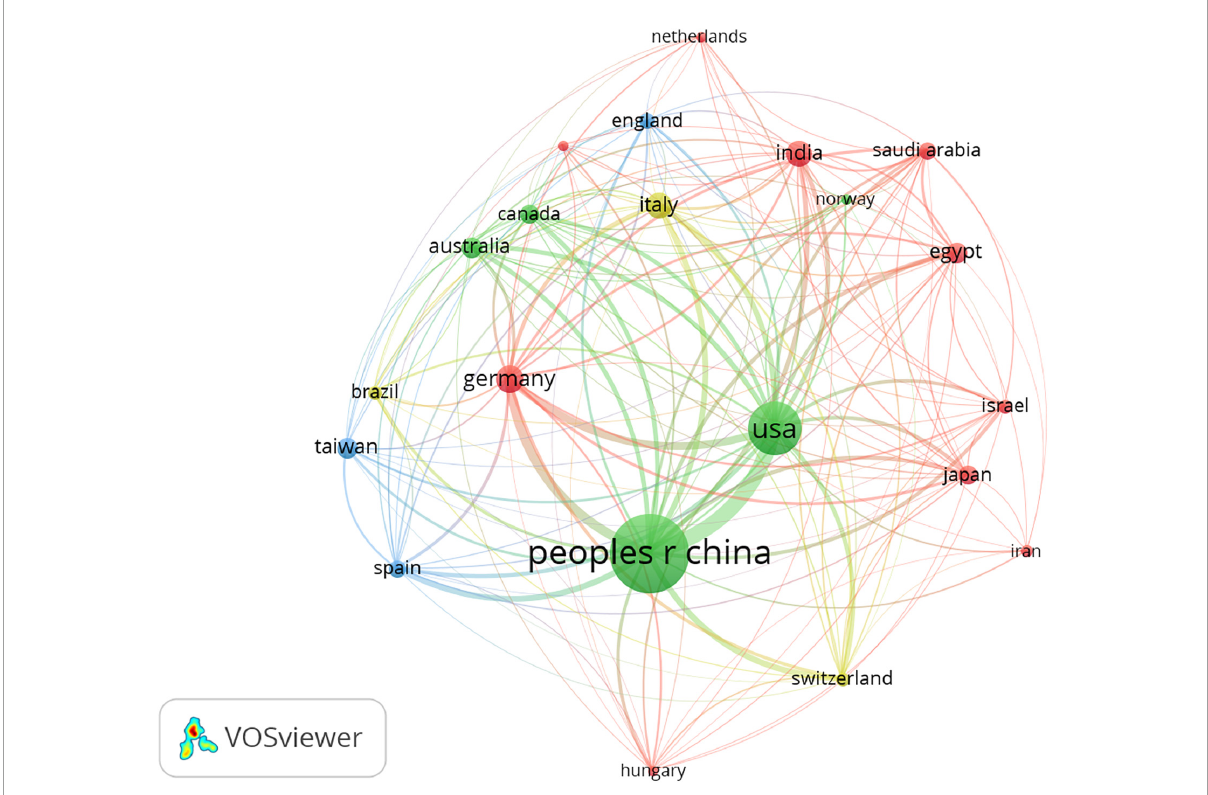
FIGURE2 Network map of countries/regions in inflammation related to diabetic cardiomyopathy (DCM) research. The analysis method was Linlog/modularity in VOSviewer, the weight was an occurrence, and scores were the average published year.